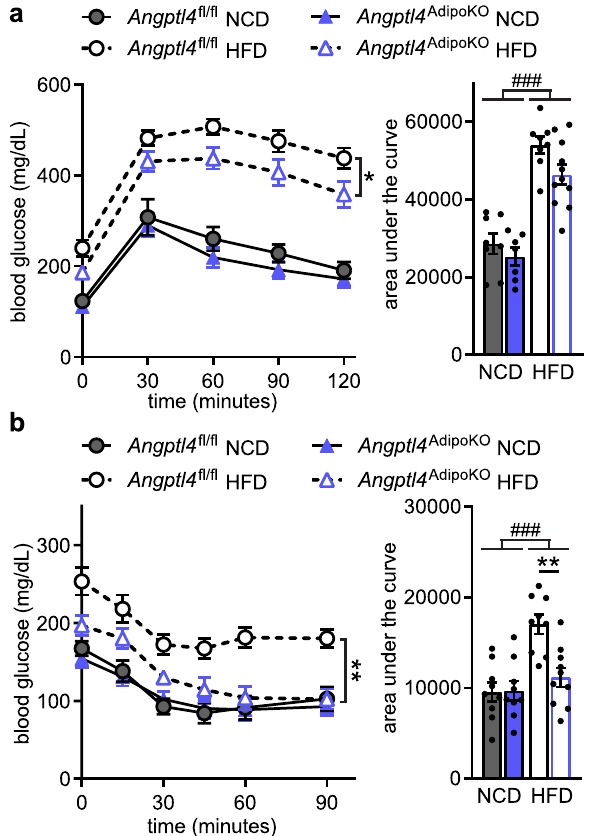
Figure 4. Glucose tolerance and insulin sensitivity of Angptl4 AdipoKO mice. ( a ) Glucose tolerance tests were performed on fasted (6 h) male Angptl4 fl/fl and Angptl4 AdipoKO mice after 11 weeks of either a normal chow diet (NCD) or high fat diet (HFD). Blood glucose concentrations were measured over 2 h after injection with glucose. Points represent glucose levels (mean ± SEM; n = 8–11) at each respective time point. *p < 0.05 by repeated measures ANOVA. Bar graphs represent area under the curve (mean ± SEM) for all time points. ###p < 0.001 for dietary differences by two-way ANOVA. ( b ) Insulin tolerance tests were performed on fasted (4 h) male Angptl4 fl/fl and Angptl4 AdipoKO mice after 12 weeks on diet. Blood glucose concentrations were measured over 90 min after injection with insulin. Points represent glucose levels (mean ± SEM; n = 9–10) at each respective time point. **p < 0.01 for individual genotype-specific differences by repeated measures ANOVA. Bar graphs represent area under the curve (mean ± SEM) for all time points. ###p < 0.001 for dietary differences by two-way ANOVA. **p < 0.01 for individual genotype-specific differences by multiple comparison after two- way ANOVA (Tukey